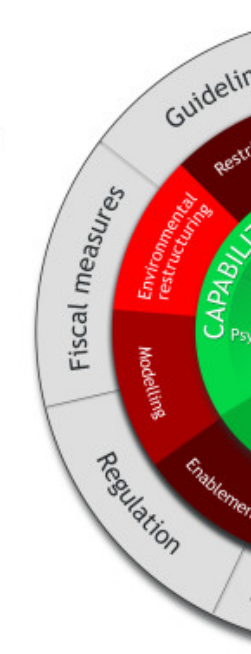
Figure 1. The behaviour change wheel (BCW) showing at the core the capabilities (C), opportunities (O), and motivations (M) that are considered sources of behaviour. Then, the outer two layers of the wheel that outline the ways that sources of behaviour can be influenced through nine possible intervention functions (listed above) and, finally, seven policy categories (also listed above) (reproduced with permission, after Michie et al. [17]).